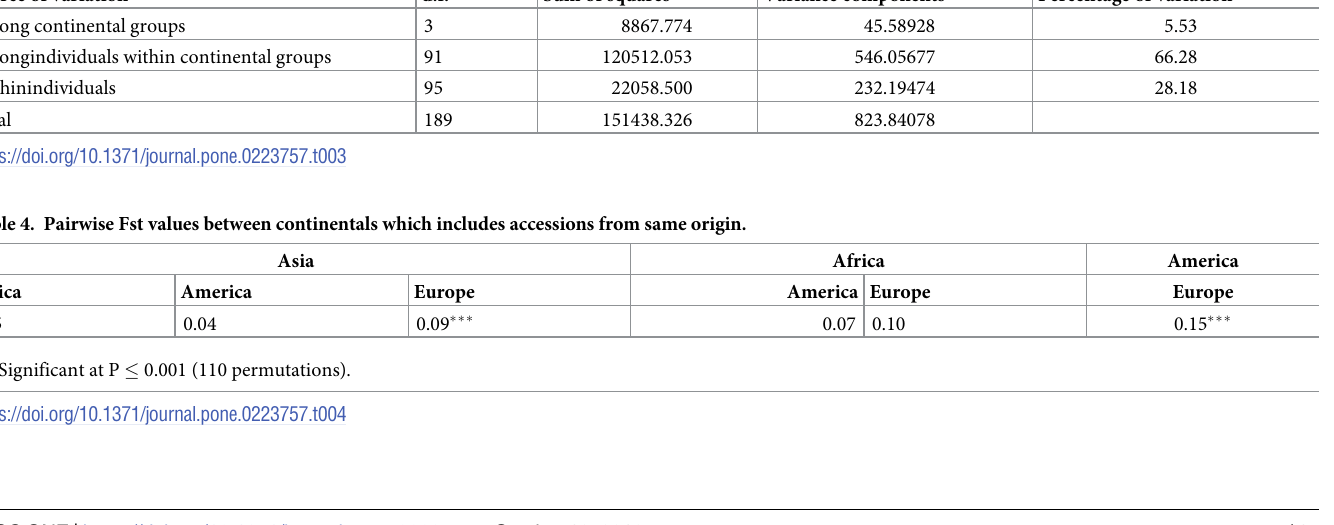
Table 3. Analysis of molecular variance (AMOVA) results for global FST statistics.